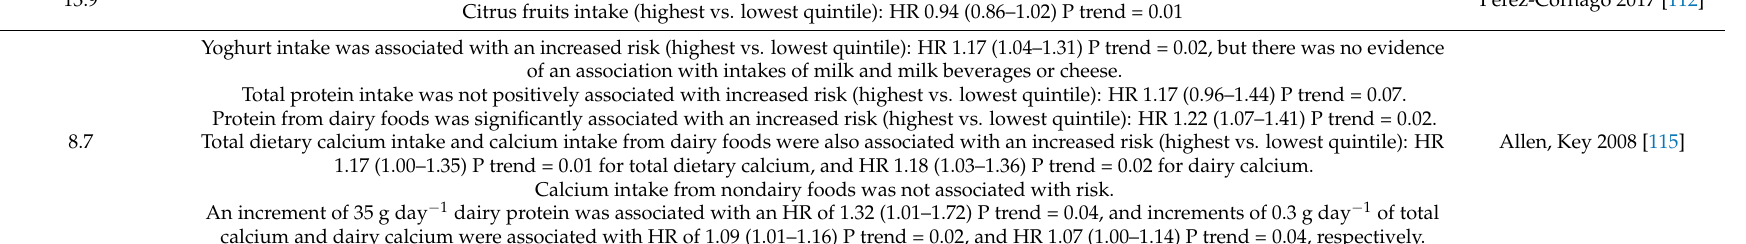
Table 4. Evidence synthesis of the association between diet and prostate cancer in the EPIC study. Wholegrains, Vegetables, and Fruit No. of